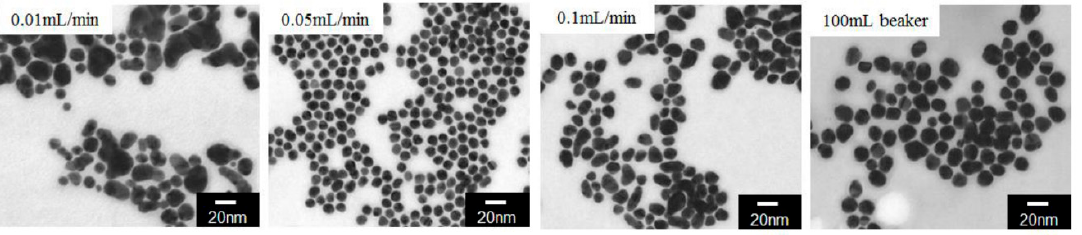
Figure 4. TEM images of the synthesized GNPs by the device at the flow rate of 0.01, 0.05, 0.1 mL/min, and by 100 mL beaker.